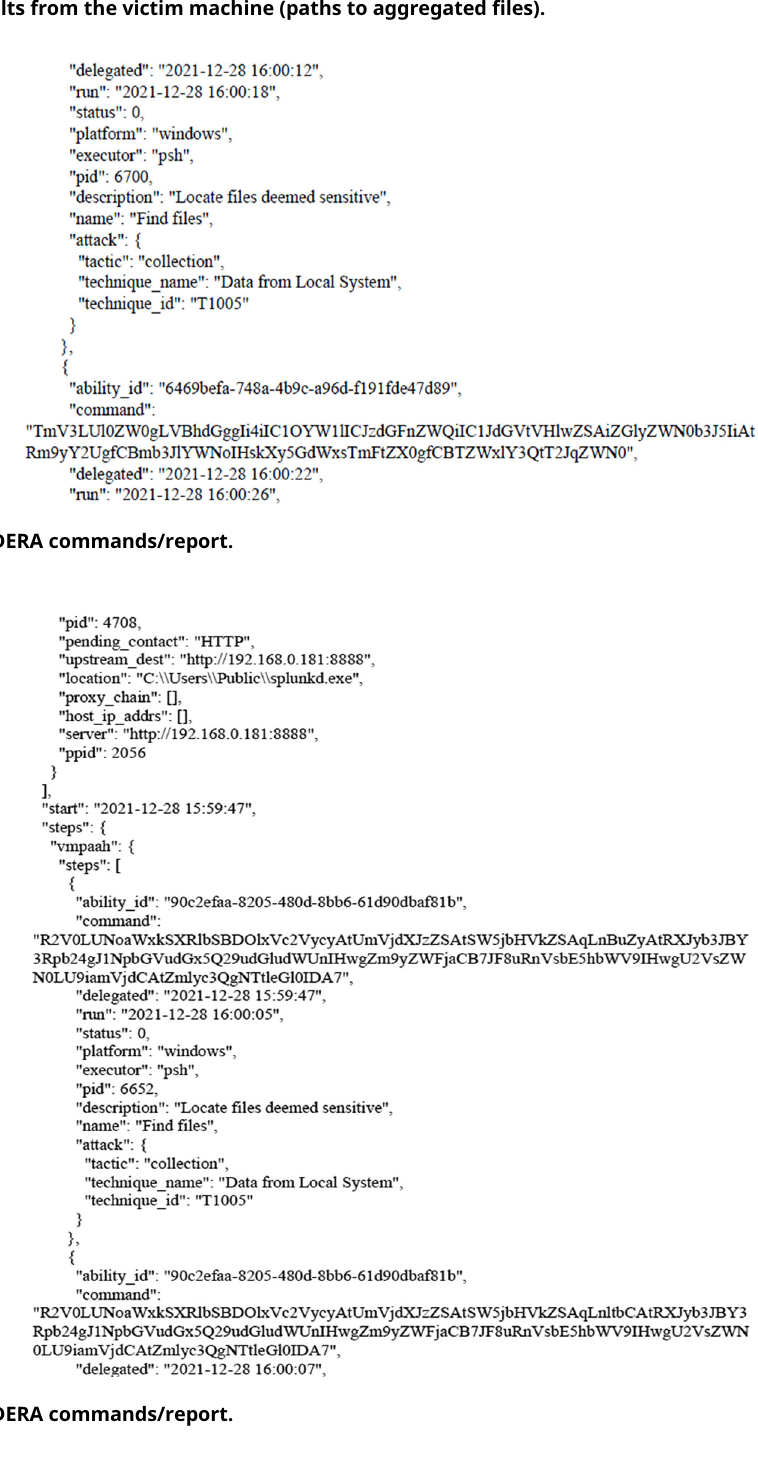
Figure 7. Results from the victim machine (paths to aggregated files).